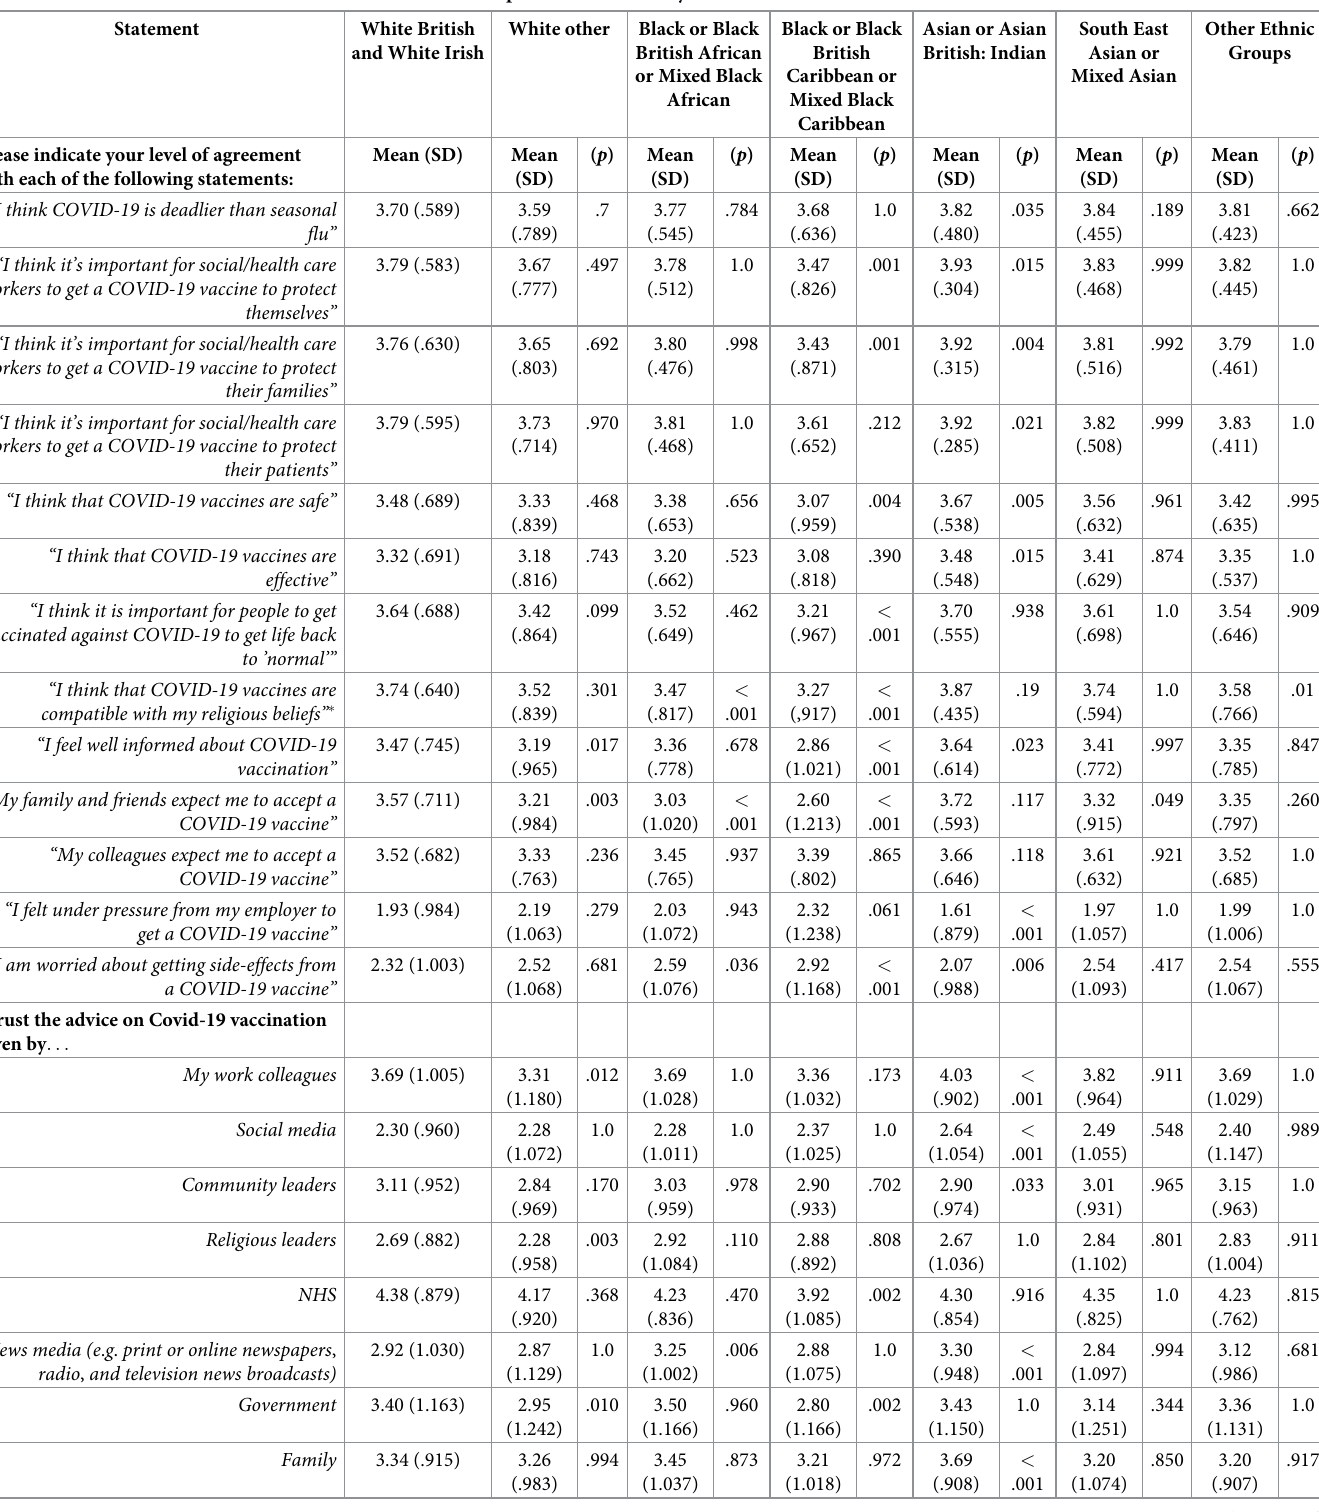
Table 7. COVID-19 belief and trust in information sources compared across ethnicity. Statement Other Ethnic